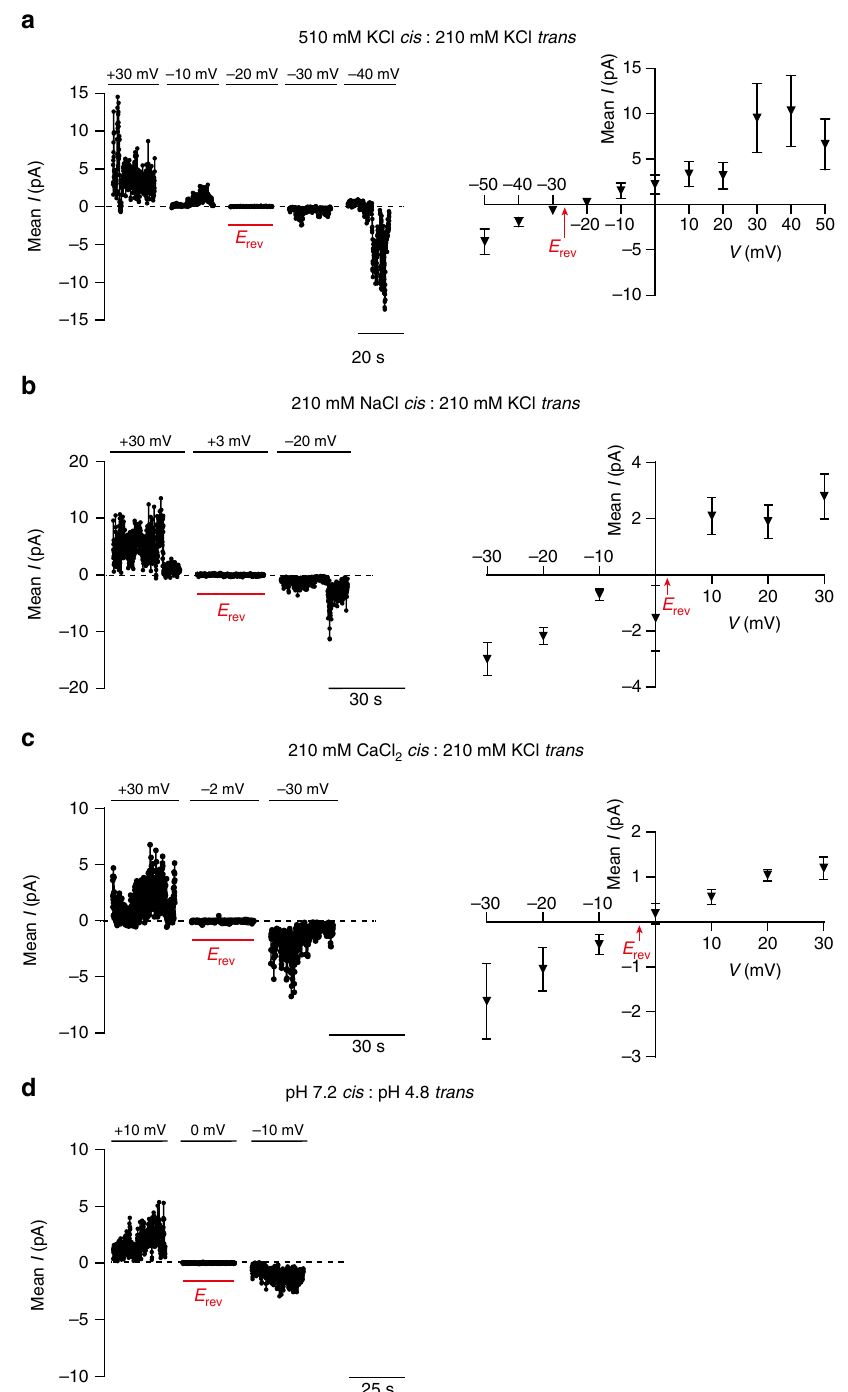
Fig. 4 Ssp6 can form cation-selective pores in vitro. Multiple pores formed by MBP-Ssp6 were incorporated into the lipid bilayer under voltage clamp conditions and the mean current was measured. a – c Noise analysis of current fl uctuations at the indicated holding potentials (left panels) and I / V relationship (right panels) for MBP-Ssp6 under conditions of: ( a ) a KCl gradient (510 mM cis chamber:210 mM trans chamber); ( b ) Na + in the cis chamber (210 mM NaCl) and K + in the trans chamber (210 mM KCl); and ( c ) Ca 2 + in the cis chamber (210 mM CaCl 2 ) and K + in the trans chamber (210 mM KCl). d Noise analysis of current fl uctuations at − 10 mV, 0 mV and + 10 mV under conditions of symmetrical 210 mM K + acetate with the cis chamber at pH 7.2 and the trans chamber at pH 4.8. a – d The dotted line in each current trace shows the zero current level (left panels); points for I / V relationships (right panels) show mean + / − SEM ( n = 3 independent experiments, except part a where n = 4); reversal potential ( E rev ) is indicated in red. Source data are provided as a Source Data fi